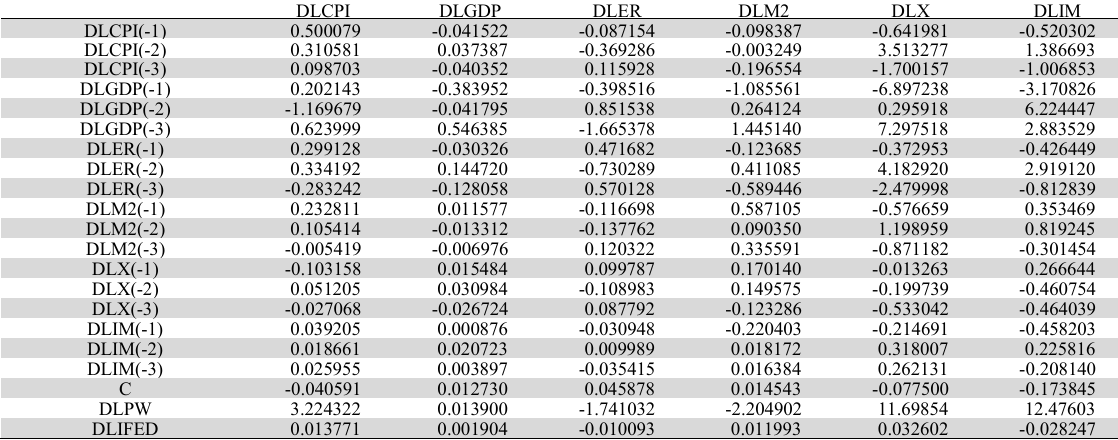
Estimated results of VAR model